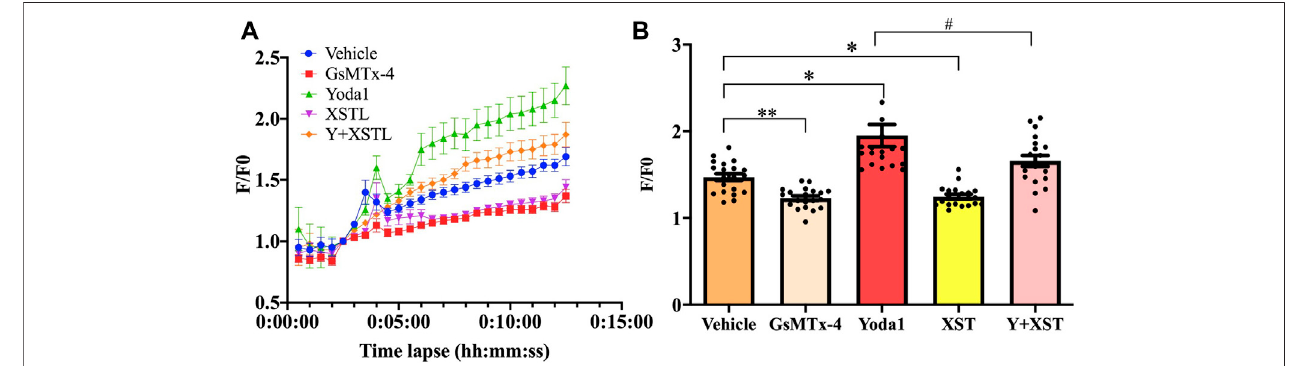
FIGURE 5 | Effects of treatment with XST on shear induced Ca 2+ responses. (A) Time-course of changes in intracellular Ca 2+ mean levels (F/F 0 ) in platelets subjected to a shear rate of 1,000 s − 1 without (vehicle) and with treatment with GsMTx-4 (2.5 µM), Yoda1 (25 µM), XST (0.15 g L − 1 ), and XST together with Yoda1. (B) Effects of treatment with GsMTx-4, Yoda1, XST or XST together with Yoda1 on shear-induced Ca 2+ responses in platelets at time point of 8.5 min. Three independent experimentswereundertaken.* p < 0.05and** p < 0.01comparedtothevehiclegroup; # p < 0.05comparedtoplateletstreatedwithYoda1alone,analyzedbyone- way ANOVA and post-hoc Tukey ’ s